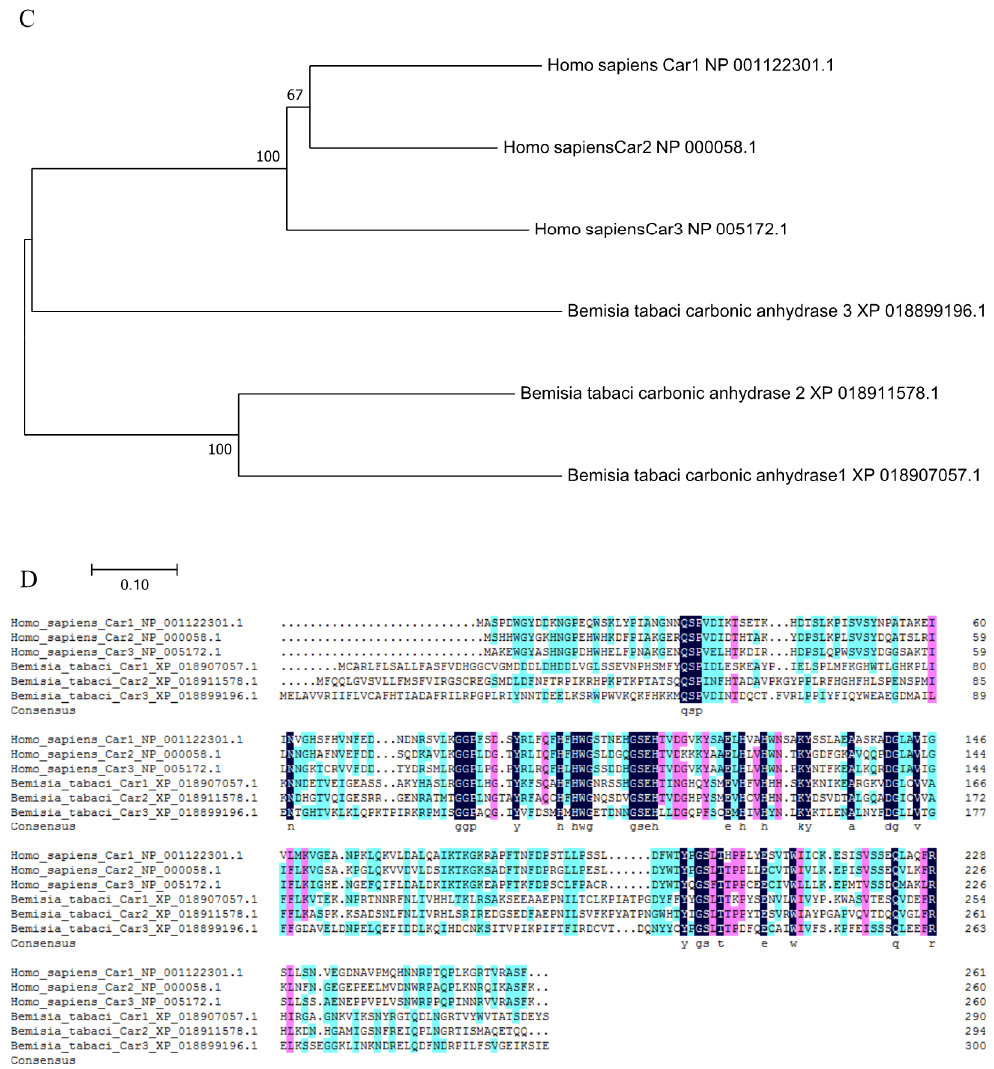
Figure 2. ( A ) The functional domain of BtCYP 4C1 . ( B ) Phylogenetic analysis based on amino acid Scheme 1. Car2 and Car3. ( C ) Phylogenetic analysis based on amino acid sequences of Car1, Car2 and Car3 from Homo sapiens and Bemisia tabaci . ( D ) The multiple alignment of the deduced amino acids of Cars in Homo sapiens and Bemisia tabaci .